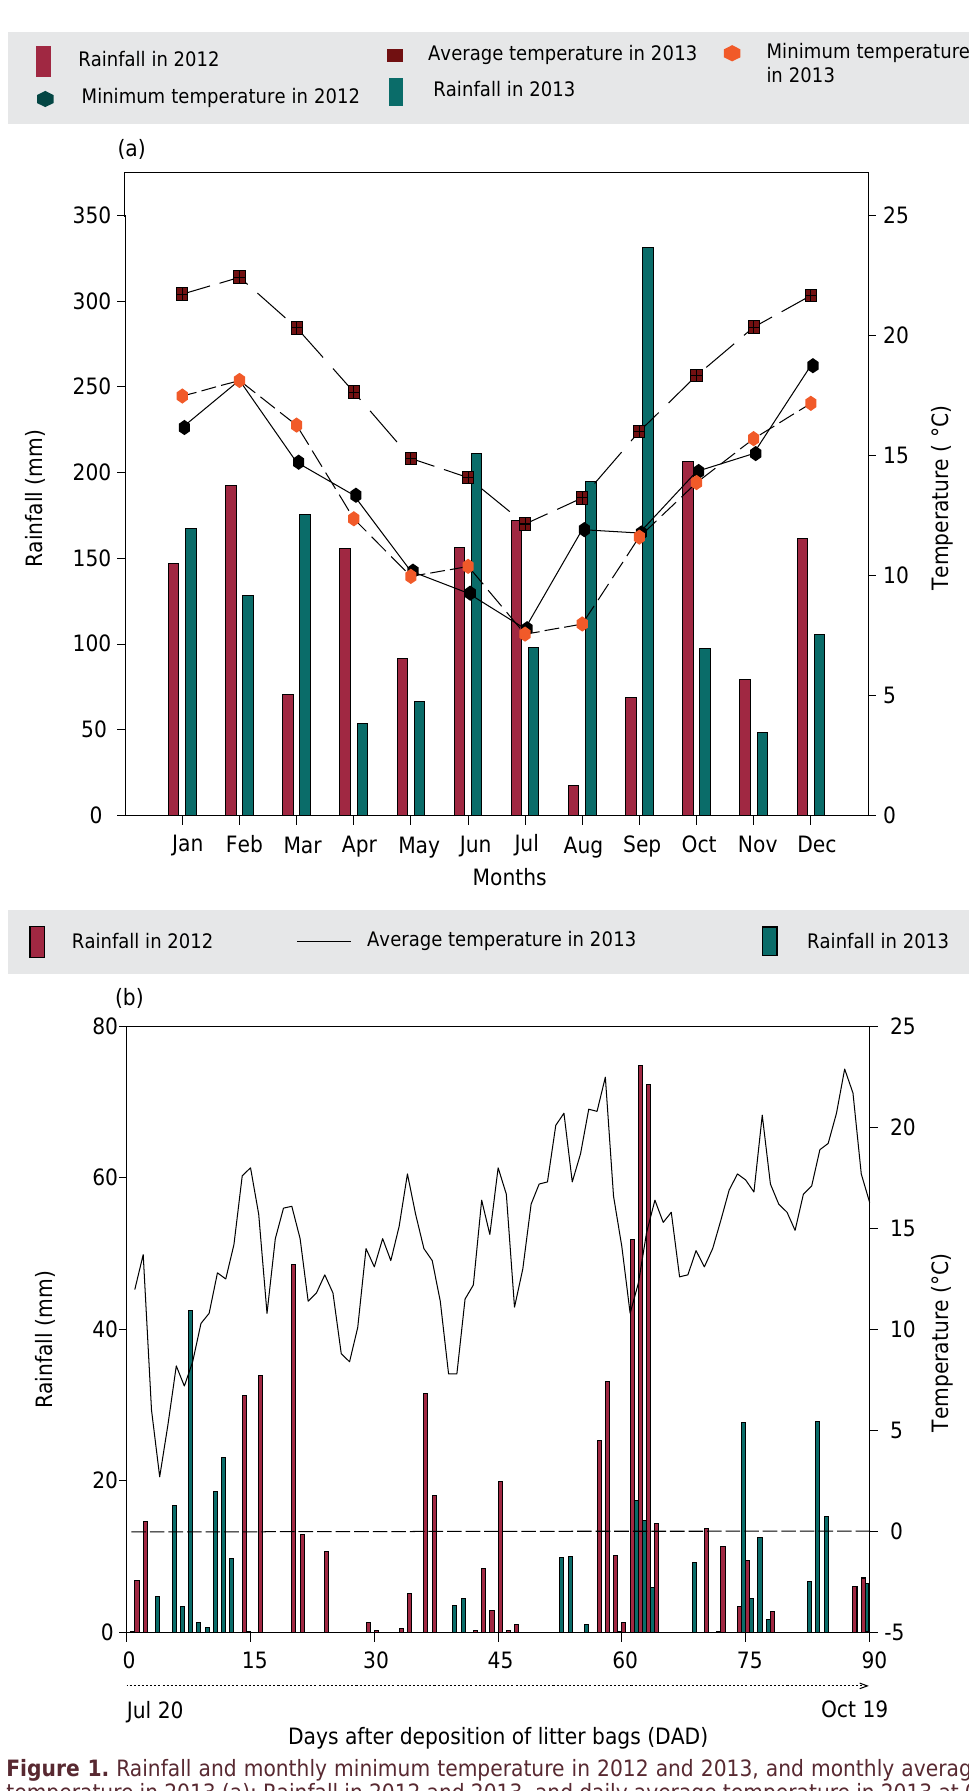
Figure 1. Rainfall and monthly minimum temperature in 2012 and 2013, and monthly average temperature in 2013 (a); Rainfall in 2012 and 2013, and daily average temperature in 2013 at 0, 30, 45, 60, 75, and 90 DAD in the experimental area